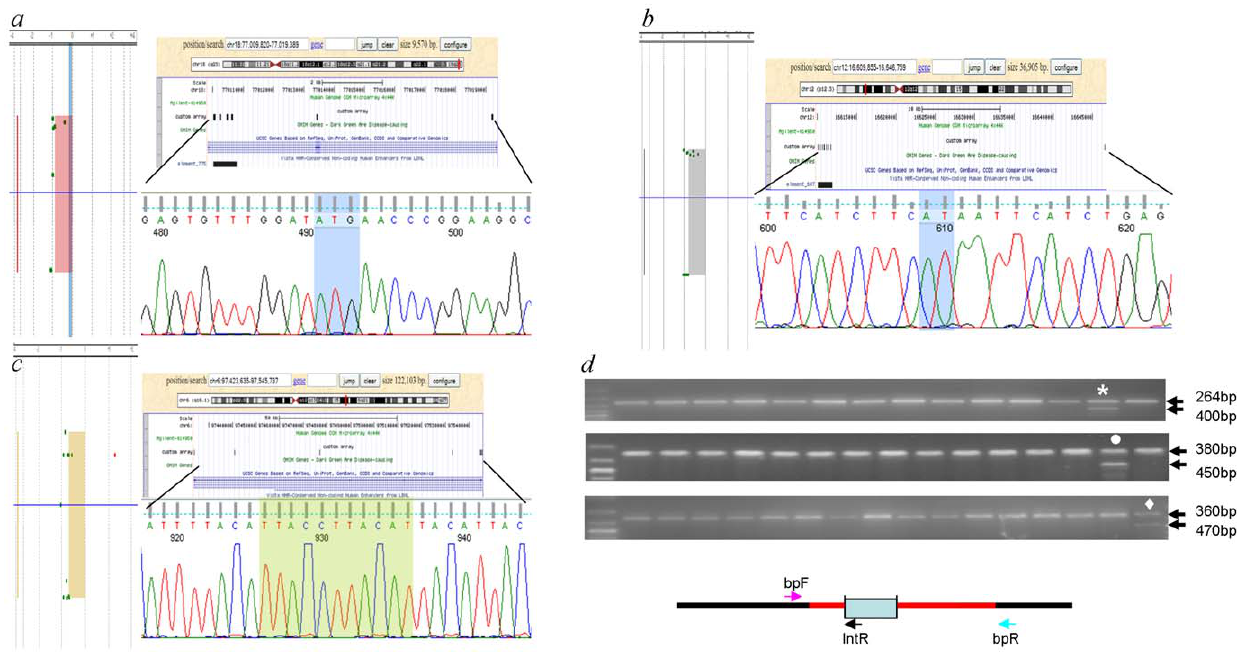
Figure 2. New CNVs overlapping VISTA enhancers. aCGH results for sample 1 ( a ), 25 ( b ) and 27 ( c ) showing deletions overlapping enhancers hs775, hs676 and hs607, respectively. ( d ) Genotyping assay for deletions in enhancers hs775 (upper panel), hs676 (middle panel) and hs607 (lower panel): triplex PCR with a forward primer (bpF) located 5’ to the breakpoint, a reverse primer within the deleted region (in red) and a second one 3 9 N the distal breakpoint (box represents the enhancer elements). Bands of 264 bp, 380 bp and 360 bp, respectively, correspond to bpF-IntR amplicons, in middle panel) and 27 ( ¤ in lower panel) show, the lower bands represent bpF-bpR amplicons. Only sample 1 (* in upper panel), 25 ( respectively, the double bands, all the other analyzed samples show a normal pattern.